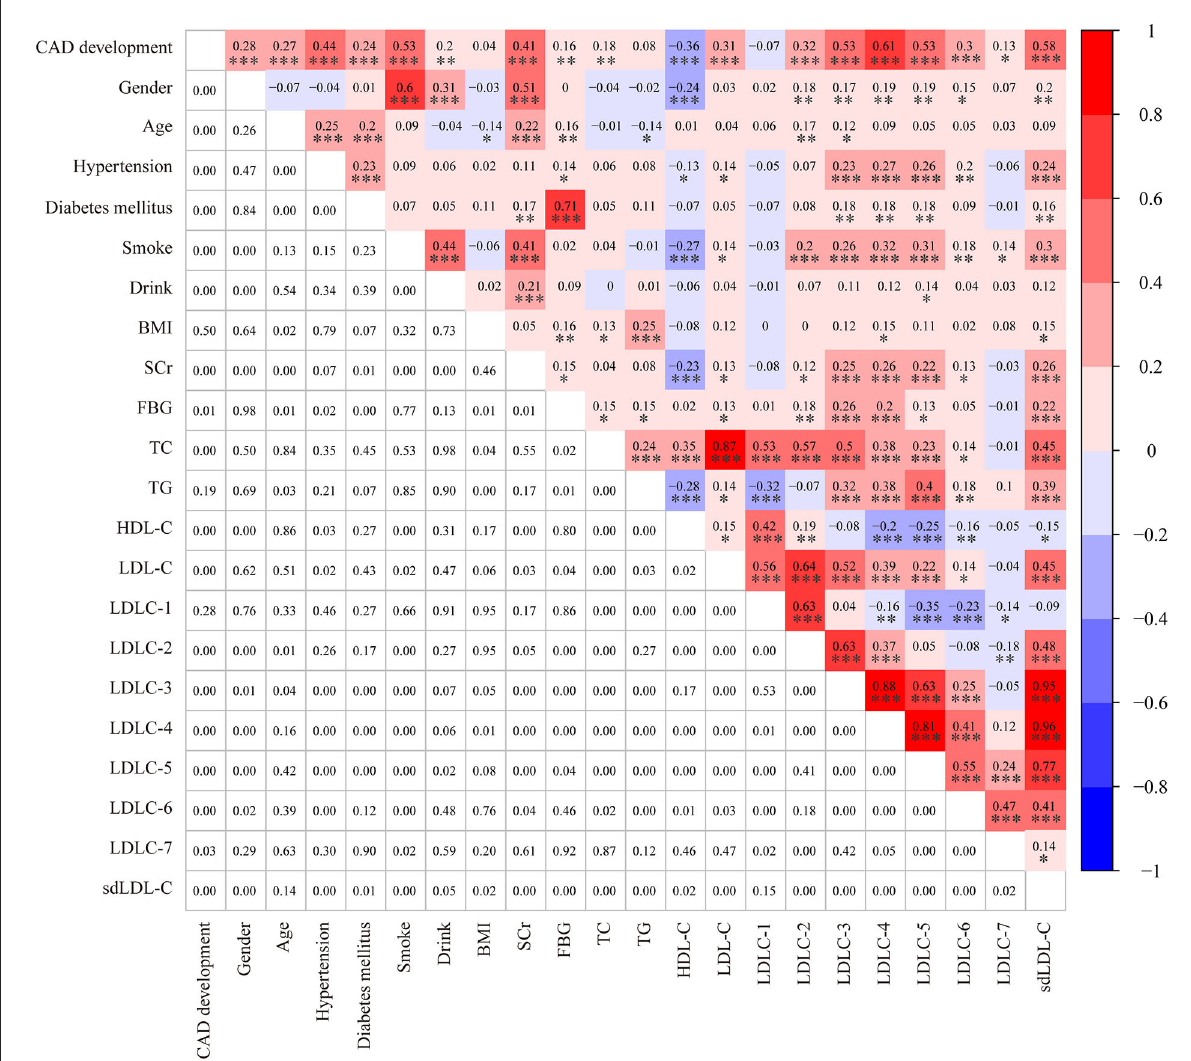
FIGURE2 A heatmap showing the results of the Spearman correlation test among clinical characteristics and laboratory. The value in the grids of the upper triangle is the Spearman correlation coefficient ( r ), which is marked by colors. The value in grids of the lower triangle is the P- value of Spearman correlation. * P < 0.05, ** P < 0.01, and *** P < 0.001.